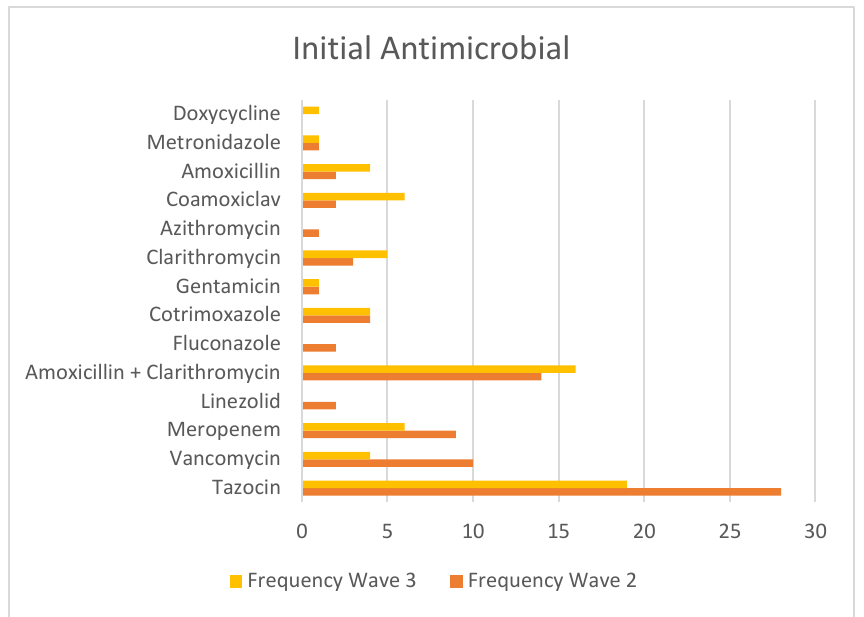
Figure 8. Table showing the frequency of each initial antimicrobial from both waves.